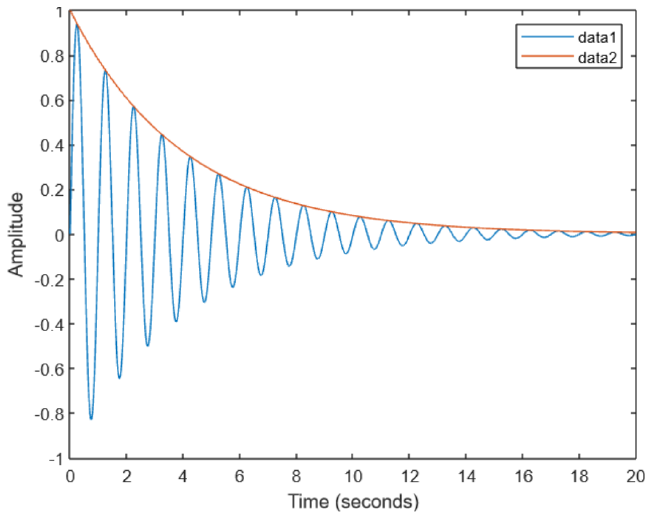
Figure 6. Stroke